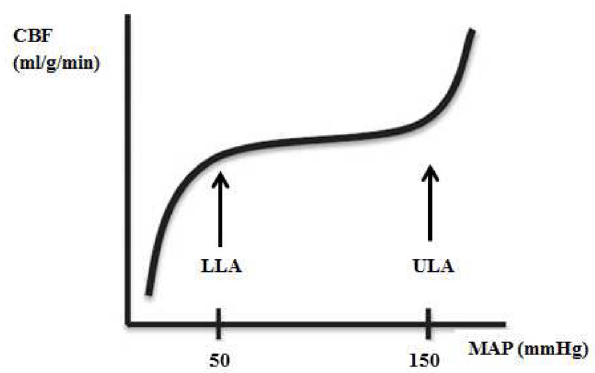
Figure 1. Classic depiction of cerebral autoregulation, with autoregulation plateau, lower limit of autoregulation (LLA), and upper limit of autoregulation (ULA). CBF, cerebral blood flow; MAP, mean arterial blood